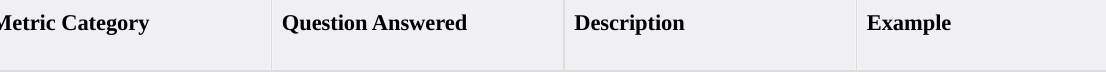
Table 1. A taxonomy of metrics: The example column Is for a hypothetical experiment introducing a new product.